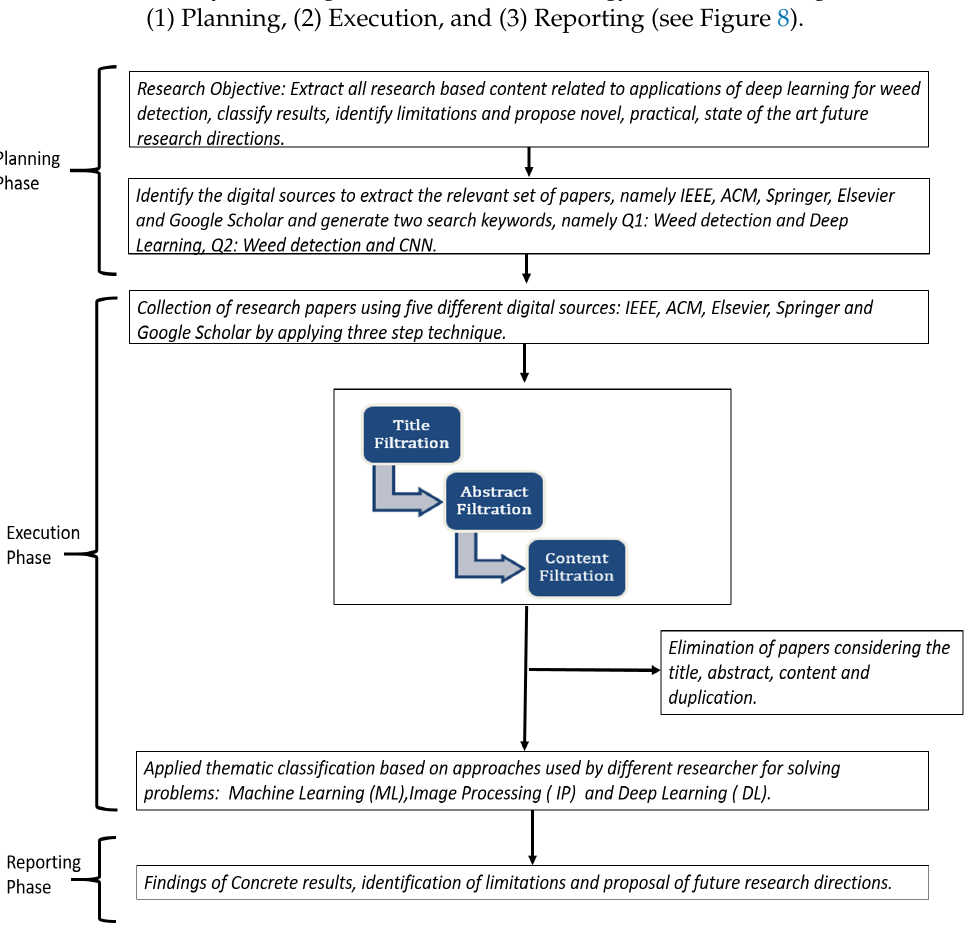
Figure 8. Our SLR